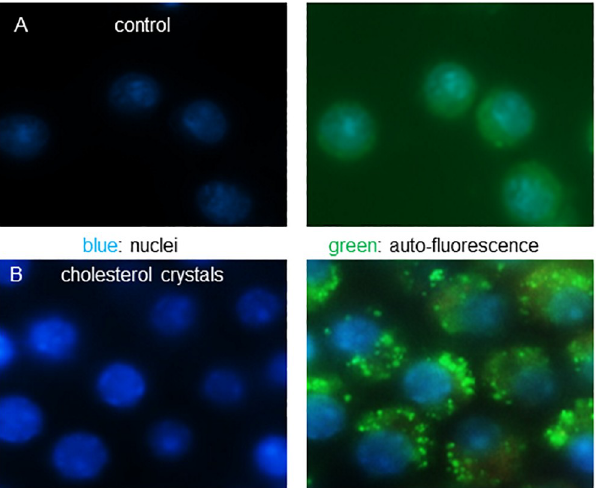
Fig 11. Cholesterol crystal uptake by J774A.1 macrophages induces auto-fluorescent puncta. Cholesterol crystals (200 μ g/ml) were added to cultured J774A.1 macrophage for 24 h and compared to vehicle treated cultures. A, Control treated cells, B, cholesterol crystal treated cell with left panels showing stained nuclei, and right panels showing auto- fluorescence and nuclei. https://doi.org/10.1371/journal.pone.0251599.g011 cholesterol crystals. Hyperspectral scans of both SIV + and control plaques indicated the needle shaped crystals had a cholesterol-ester dominant signature. Atherosclerotic plaques in HIV + coronary arteries displayed both cuboidal and needle crystals, and again both had a cholesterol ester dominate spectral signature, as did plaques from the high fat fed Ldlr -/- mice. Ex vivo , bone marrow derived macrophages from the atherosclerotic Ldlr -/- mice displayed a more